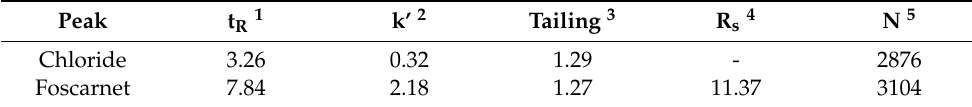
Table 6. Specificity of foscarnet peak and its relation to chloride